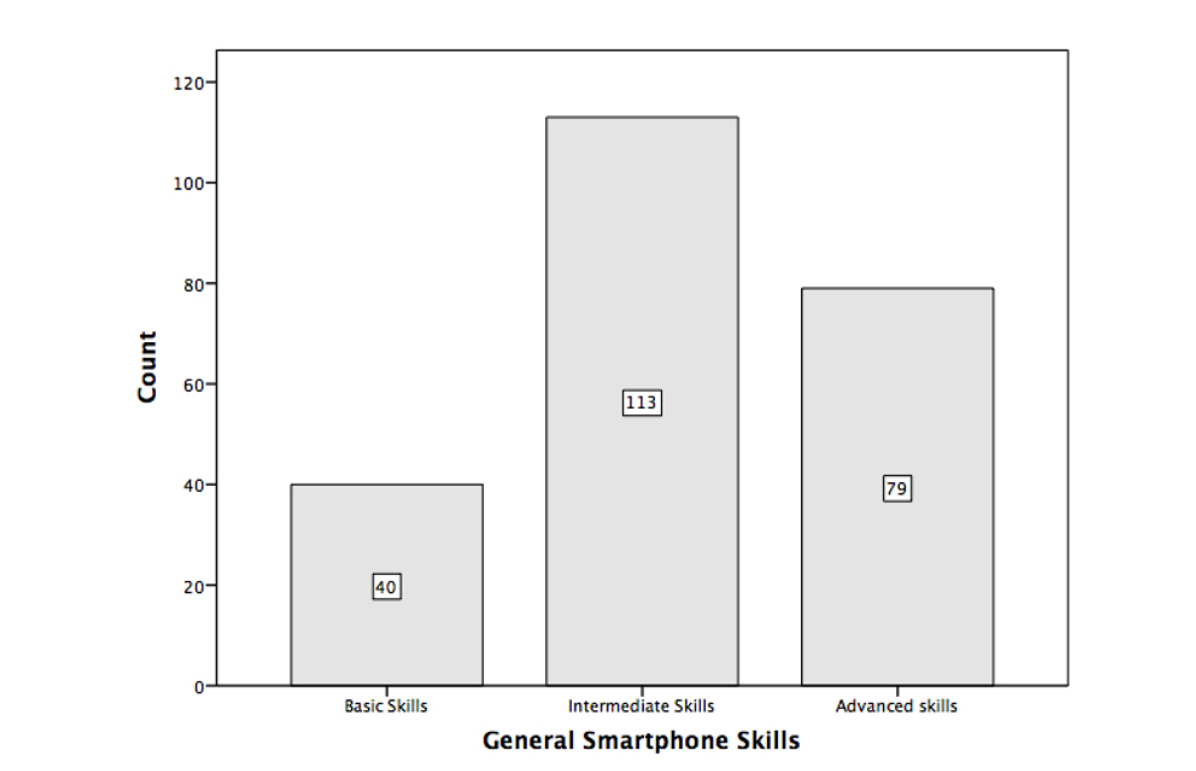
Figure 1. Number of students with basic (n=40), intermediate (n=113), and advanced skills